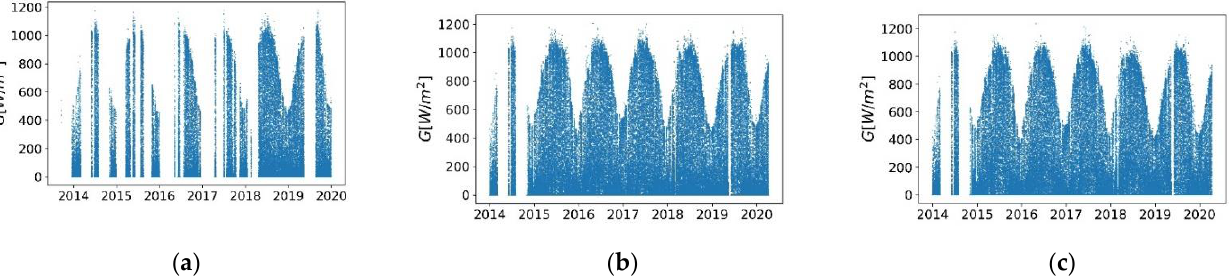
Figure 4. Visualization of the measured irradiance data ( a ) and measured irradiance with filled data gaps from a neighboring plant with orientations of 200° ( b ) and 135° ( c ).